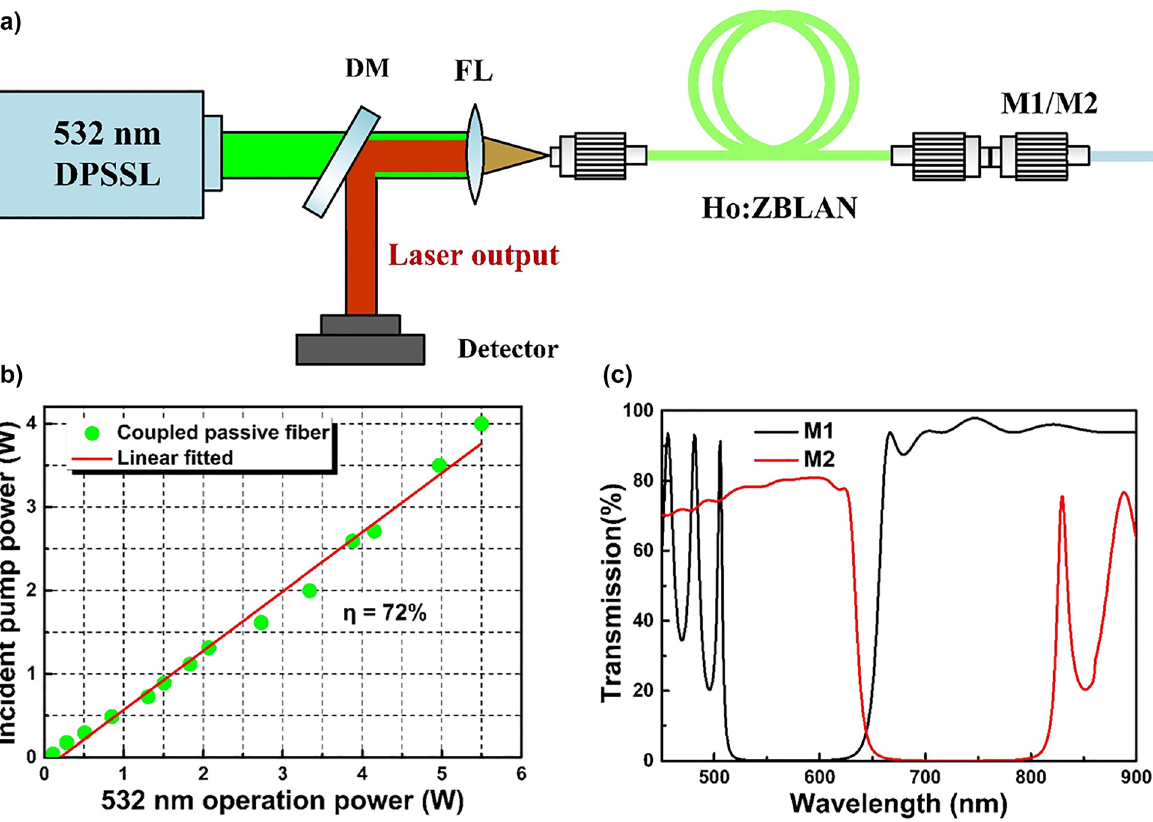
Figure 4: The configuration of deep-red fiber lasers. (a)SchematicoftheexperimentalsetupfortheHo 3 + -dopedZBLANvisible fi berlaser.(b)Incidentpumppowerasafunctionofthe532nmsolid- state laser output. (c) Optical transmission spectra of the fi ber end-facet mirror